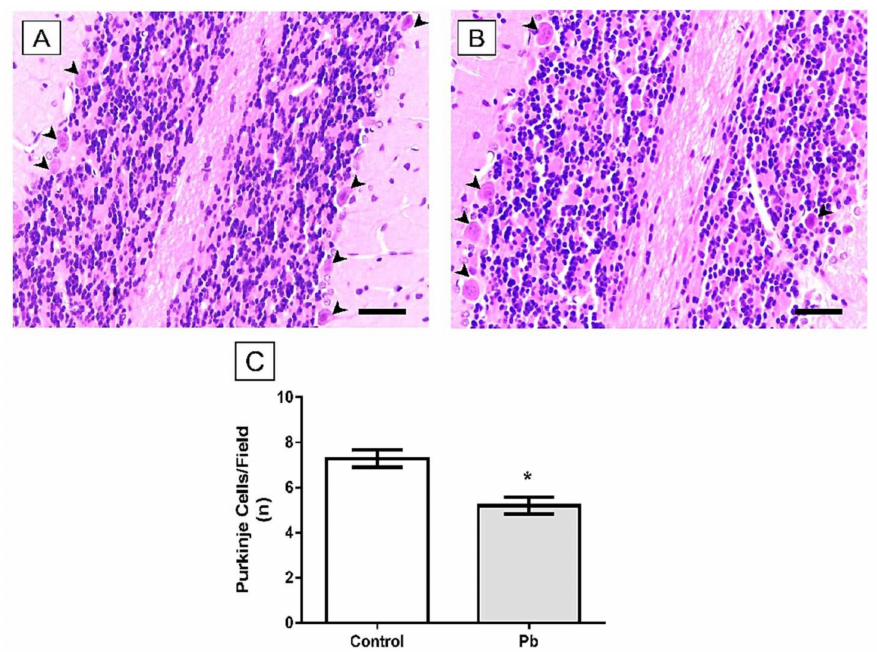
Figure 4. E ff ects of long-term exposure to Pb in the Purkinje cells (arrowhead) of cerebellum of Wistar rats. Sections were stained with hematoxylin and eosin (HE). ( A ) Control animal administered with distilled water and ( B ) animal exposed to lead. Results are expressed as mean ± standard error of ( C ) number of Purkinje cells. * p < 0.05 compared to control group (Student’s t -test). Scale bars: 30 µ